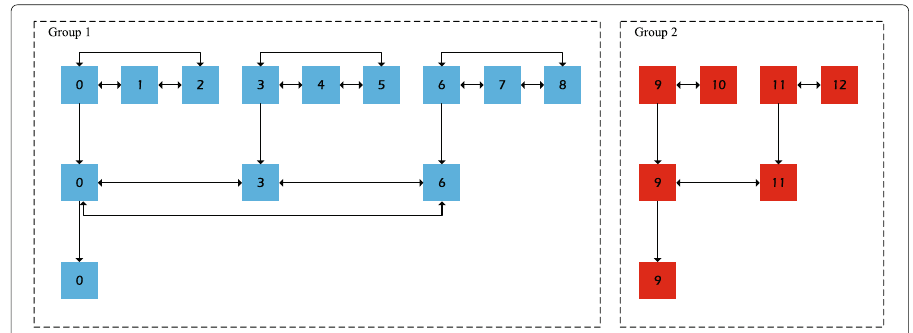
Fig. 5 Image compositing with m-ary tree. In group 1, image compositing with 3-ary tree, and in group 2, image compositing with 2-ary tree, which is also called binary